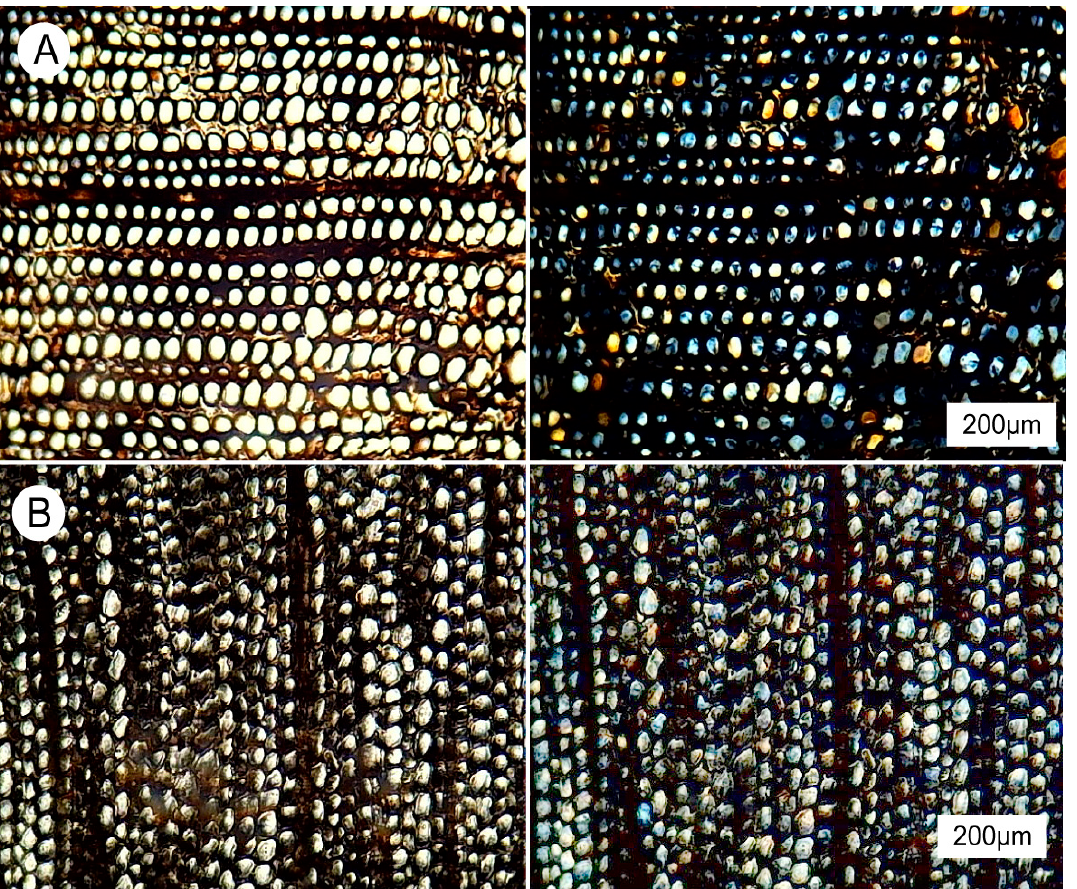
Figure 12. Transverse views of fossil wood showing ordinary transmitted light images on the left and polarized light images on the right. ( A ) Specimen T-1 (trunk 1). Birefringent opal-CT fills cell lumen. ( B ) Specimen T-12 (trunk 7) is similar in appearance to T-1, but in this specimen cell, lumina contains only quartz. The opal-CT and quartz compositions are consistent with specimen densities (e.g., 2.56 g / cm 3 for T-12, compared to 2.17 g / cm 3 for T-1).Opal-CT and quartz identifications are also supported by XRD patterns.